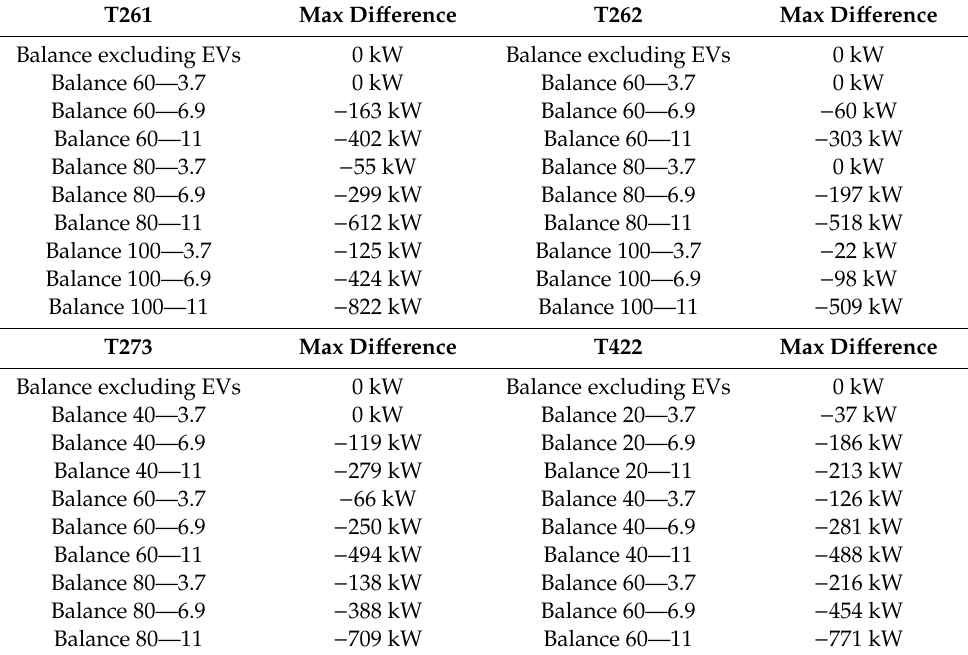
Table 4. Maximum power balance 3.7, 6.9, or 11 kW night-time